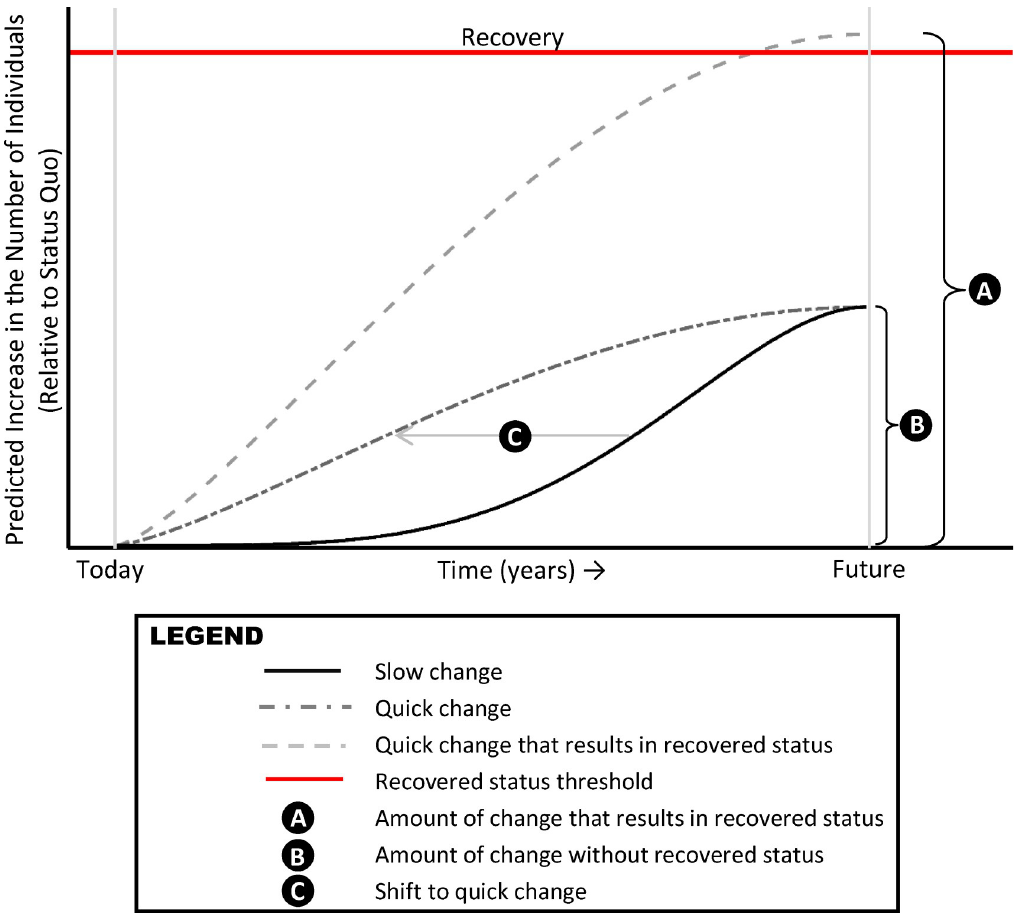
Fig 1. Alternative time paths for increasing the number of individuals of a hypothetical endangered or threatened